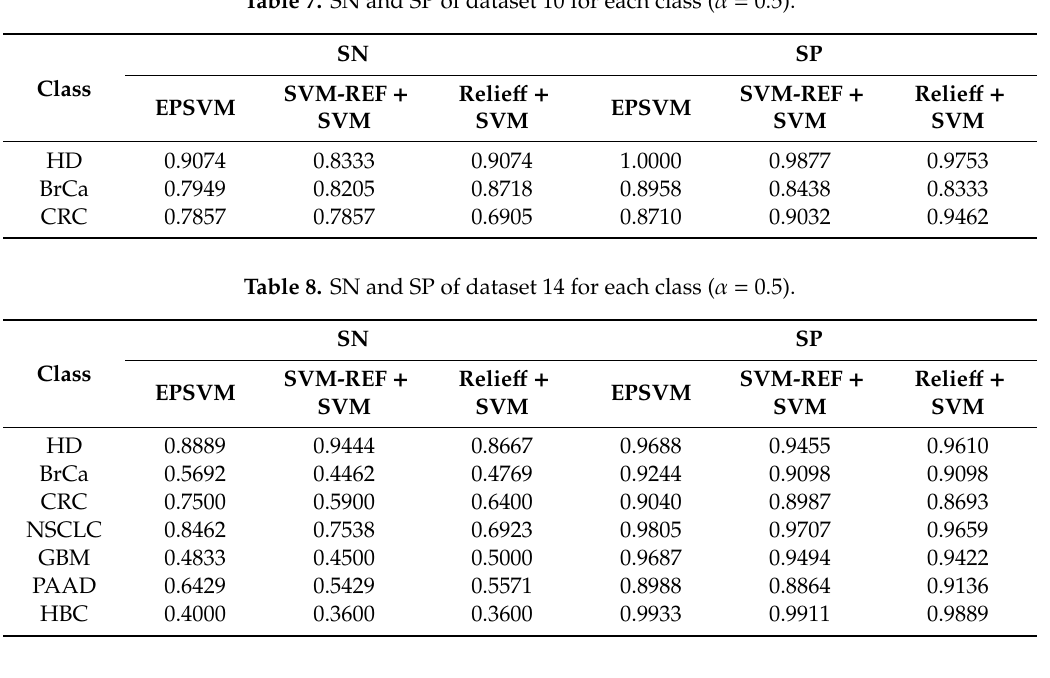
Table 7. SN and SP of dataset 10 for each class ( α = 0.5).